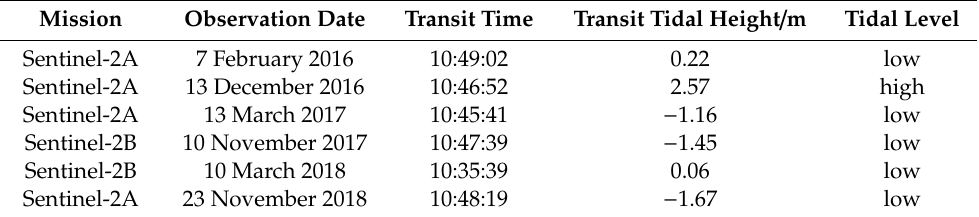
Table 2. Descriptions of selected Sentinel-2 images and instantaneous tide